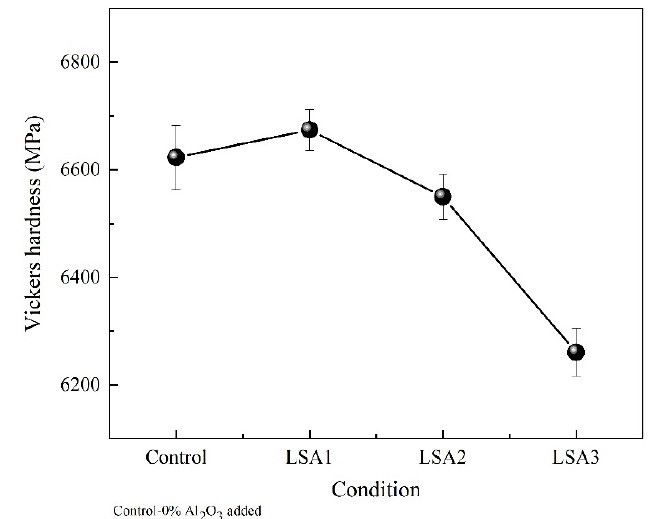
Figure 5. Vickers hardness values of the glass–ceramic samples with different Al 2 O 3 contents after heat treatment at 600/800 °C.